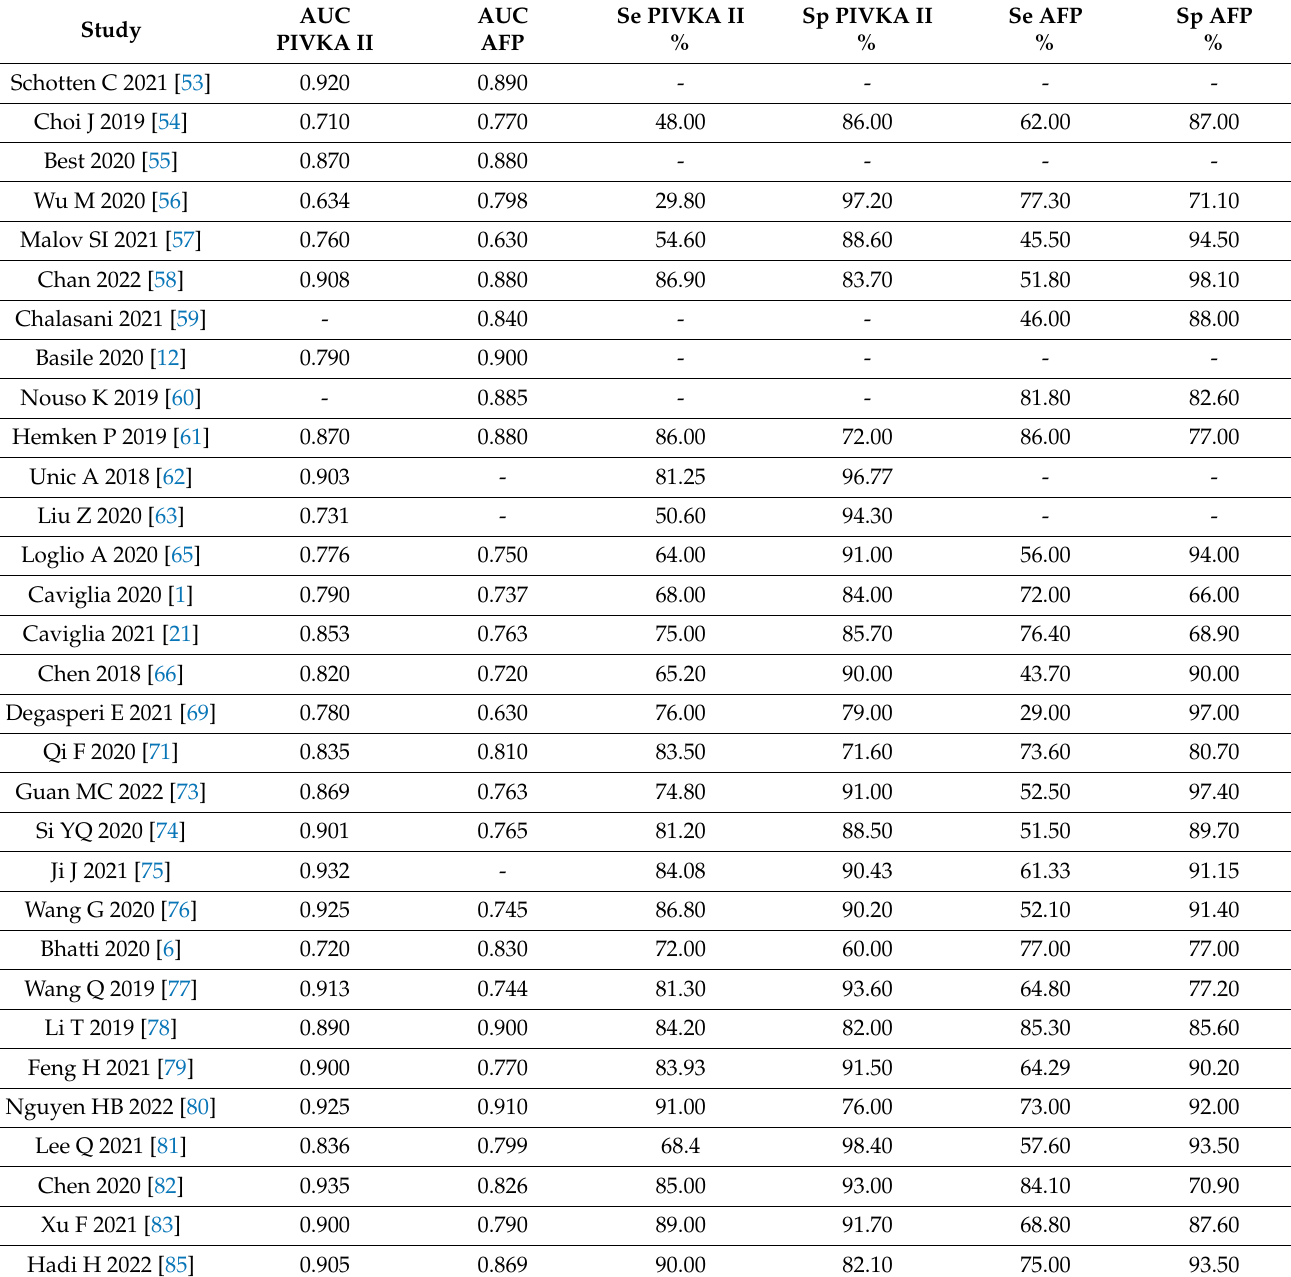
Table 2. Global HCC—Accuracy of AFP, PIVKA II for HCC diagnostic.